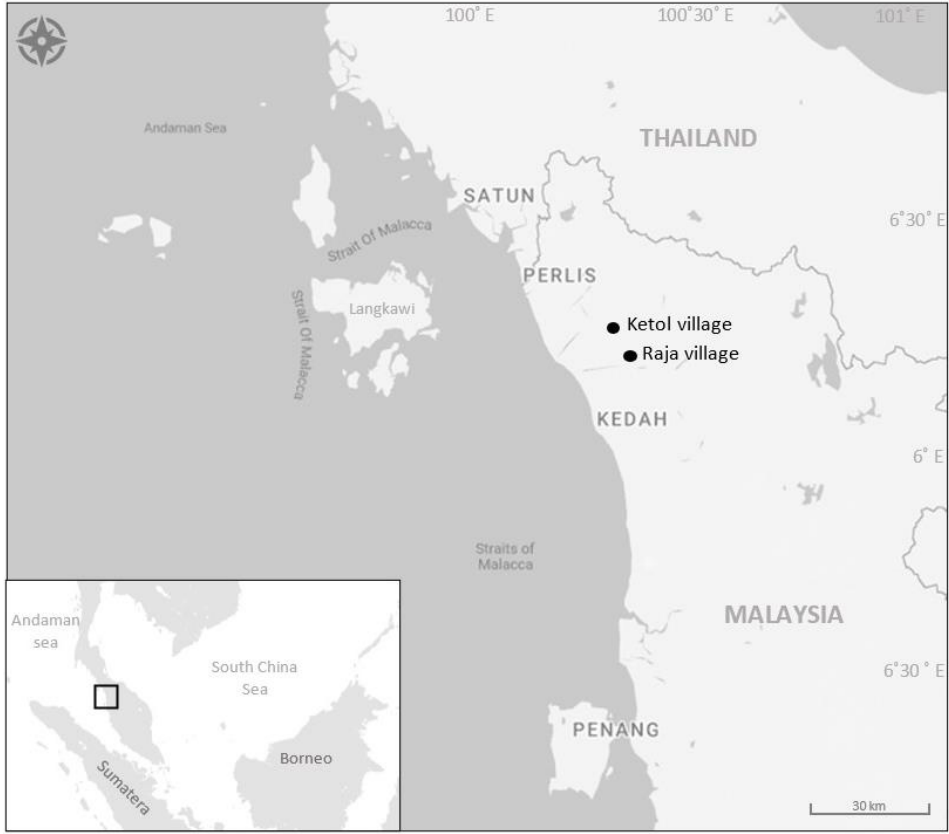
Figure 1. Map of Northern Peninsular Malaysia. The trapping sites used in this study area are marked with bold dots and labelled with the village names.